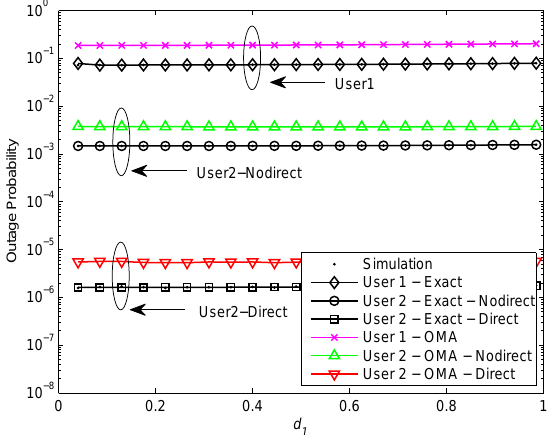
Figure 6. Outage probability versus normalized distance between BS and U 1 ( ρ = 50